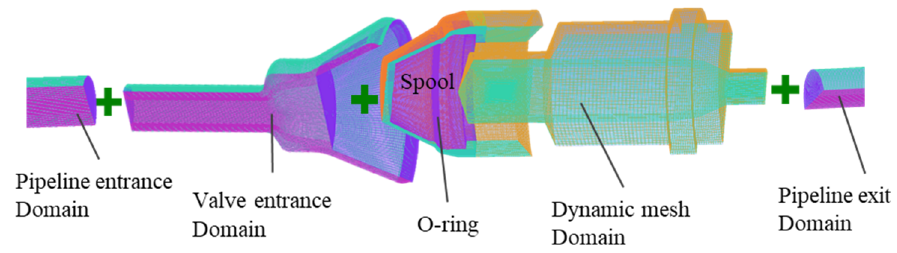
Figure 4. Structural grids of the four flow domains.